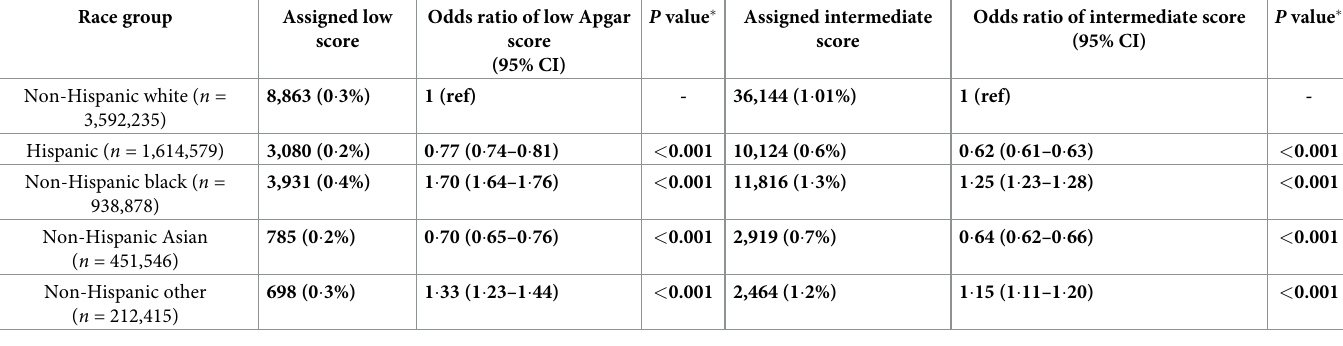
Impact of race on the relationship between 5-minute Apgar score and mortality The early neonatal, overall neonatal, and infant mortality rates decreased with increasing Apgar scores in all races (S3 Table). Across all races, low Apgar score was a strong risk factor Table 2. Unadjusted odds ratio of being assigned a low (0–3) or intermediate (4–6) Apgar score by maternal